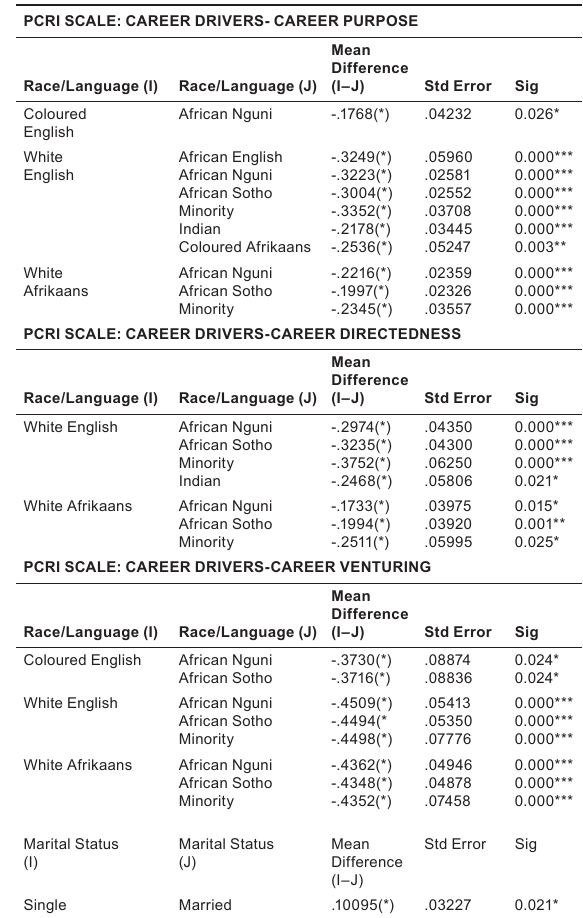
Table 8 Summary of Scheffé multiple comparison tests: Significant group mean differences on career enablers scale (N = 2